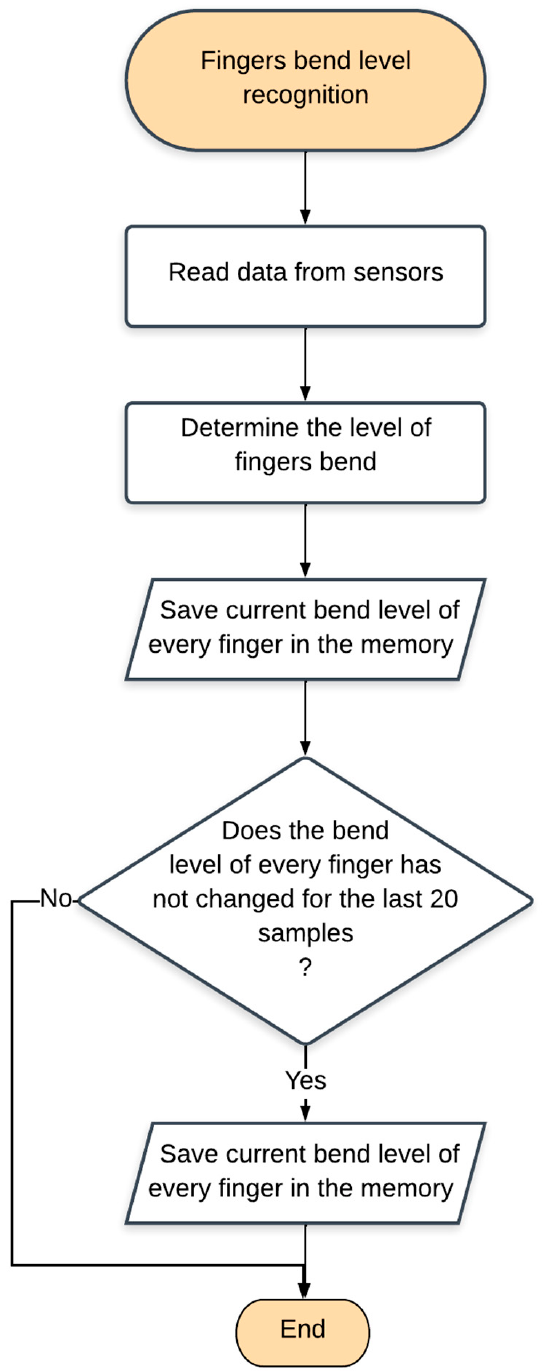
Figure 4. Algorithm showing the recognition of the bend level of the fingers. Each finger’s state can be determined by using three scale measurements. The states are: maximally bent, slightly bent (approx. 90 ◦ ), and straight. The ranges of the sensor’s data values were evaluated experimentally. The sensors were attached to the glove and pinned to the input of the A/D converter. The Min symbol means that the finger should be straightened, Mid means that the finger should be slightly bent, and Max means that the finger should be bent to the maximum. The symbols “ − ” and “+” in the accelerometer column indicate the need to recognize the hand